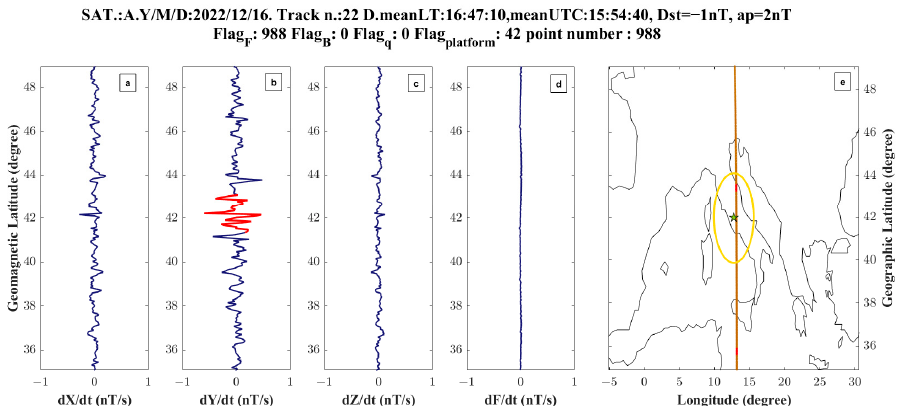
Figure 11. Swarm Bravo magnetic field analysis on 16 December 2022, track 22. The reported infor- mation is the same as in Figure 9, except for the absence of FFT spectra due to some badly flagged samples. The X, Y, and Z components are shown in ( a – c ), while the absolute scalar intensity is shown in ( d ) and the map with satellite track projection is shown in ( e ). The part of the track with bad samples is marked with red colour instead of brown.